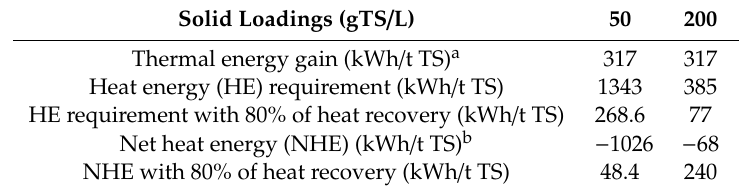
Table 4. Energy analysis for NaOH-CH 4 . The solids loadings of 50 and 200 g / L were considered.